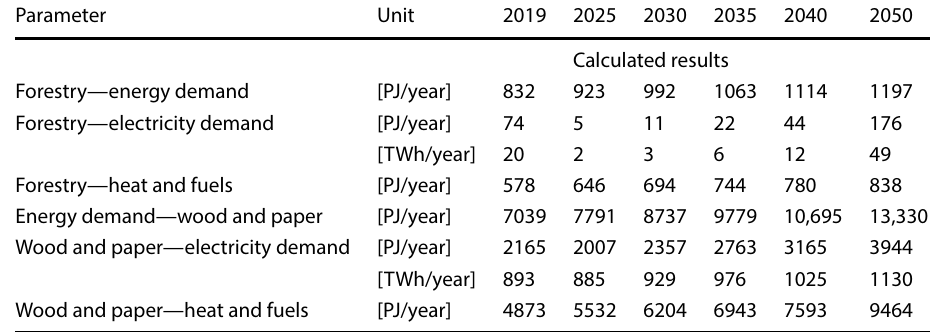
Table 10 Results: energy demand for the forestry and wood products